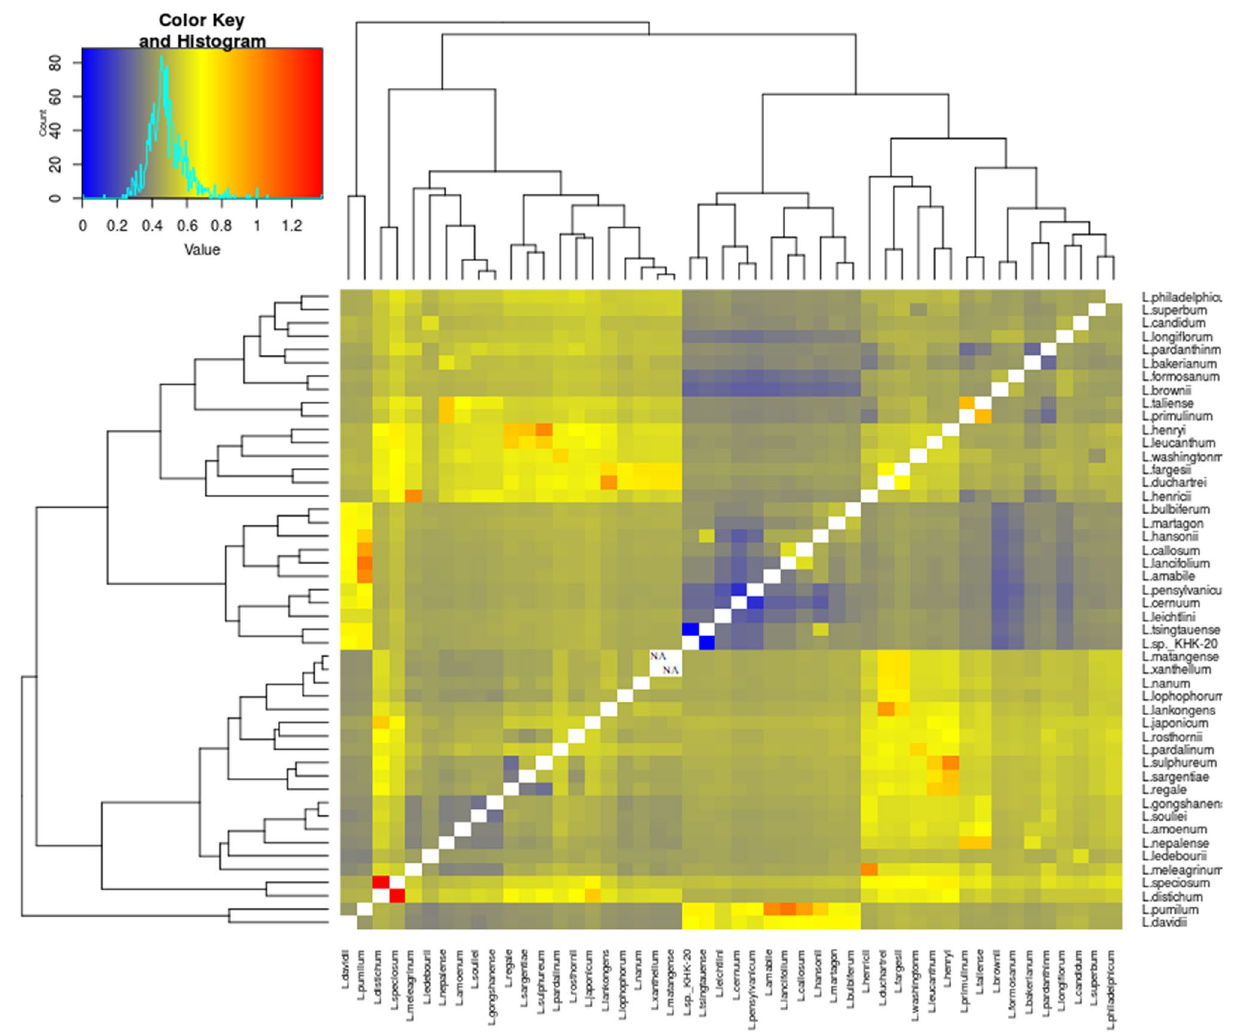
Figure 6. Ka/Ks ratios between Lilium cp genome pairs. In the multigene nucleotide alignment, the heatmap depicts pairwise Ka/Ks ratios between each concatenated single-copy CDs